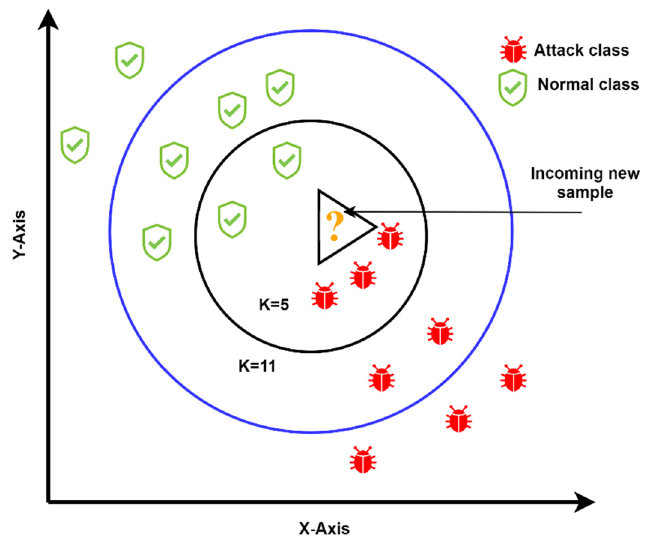
Figure 3. The IKNN method predicts new data as an attack or normal, based on different K-values and distance equations.